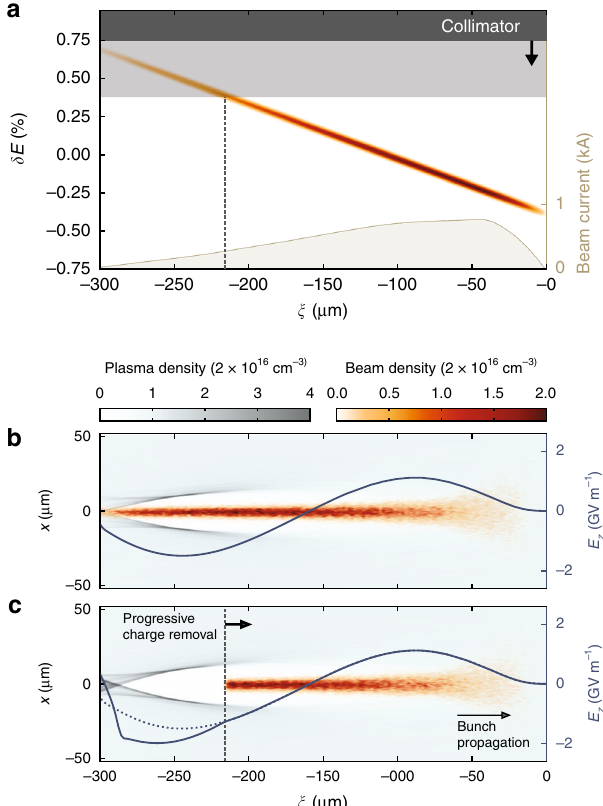
Fig. 1 Plasma wake fi eld sampling by energy collimation. a A strongly correlated longitudinal phase space allows tail slices to be progressively removed from the bunch, e.g., by collimation in a dispersive section. b An electron bunch interacts with a plasma and excites a density wake with strong longitudinal electric fi elds (3D particle-in-cell simulation). c Removing charge from the bunch tail alters the wake fi eld (compared to the original fi eld, dotted line), but does not alter the wake fi eld experienced by the remaining bunch charge. By subtracting the fi nal energy spectrum of consecutive collimator steps, the energy change of each longitudinal slice can be determined — revealing the effective wake fi